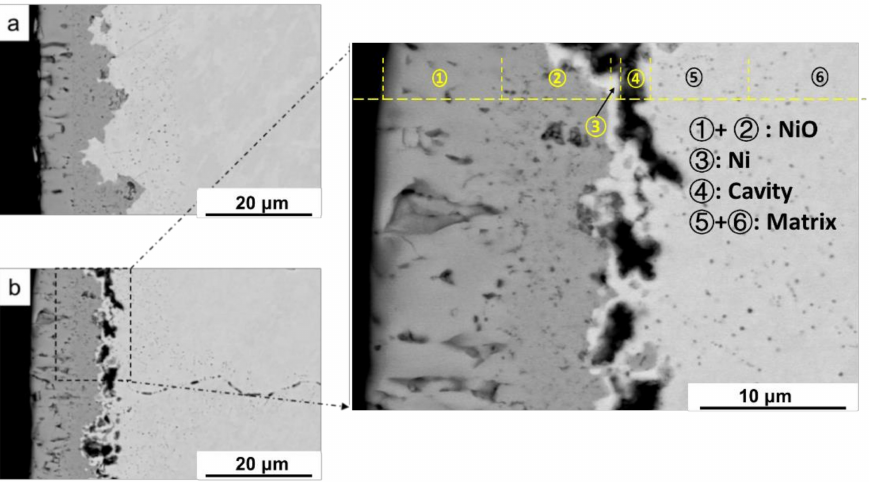
Figure 1. Magnified cross-sectional morphologies of ( a ) Ar- and ( b ) H-charged metallic Ni